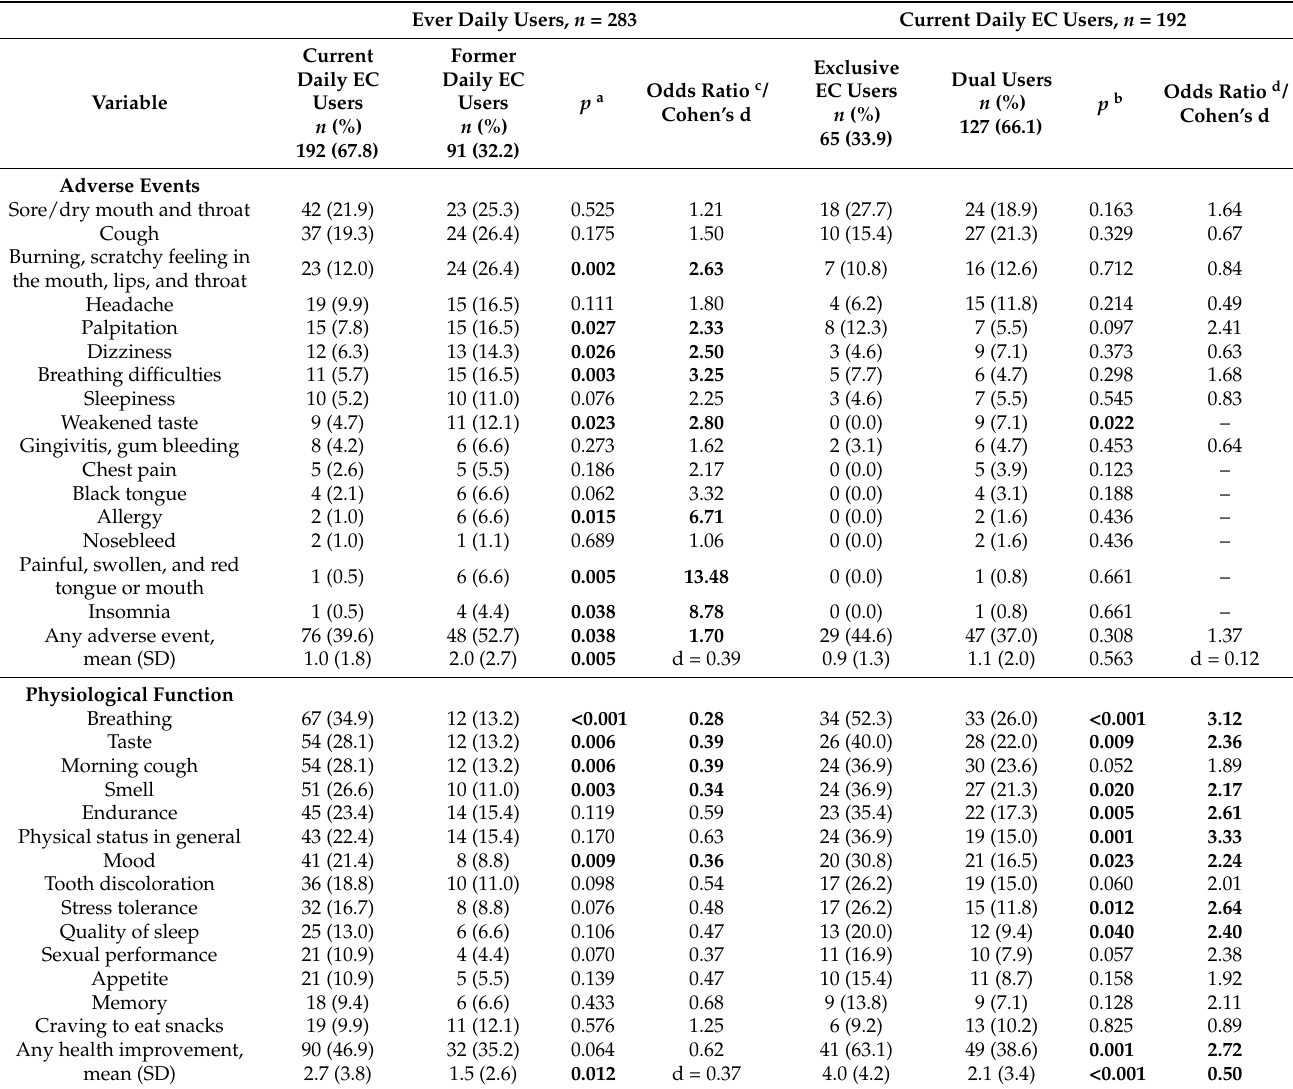
Table 2. Prevalence of vaping-related adverse events and perceived improvements in physiological functions among current daily e-cigarette users and former daily e-cigarette